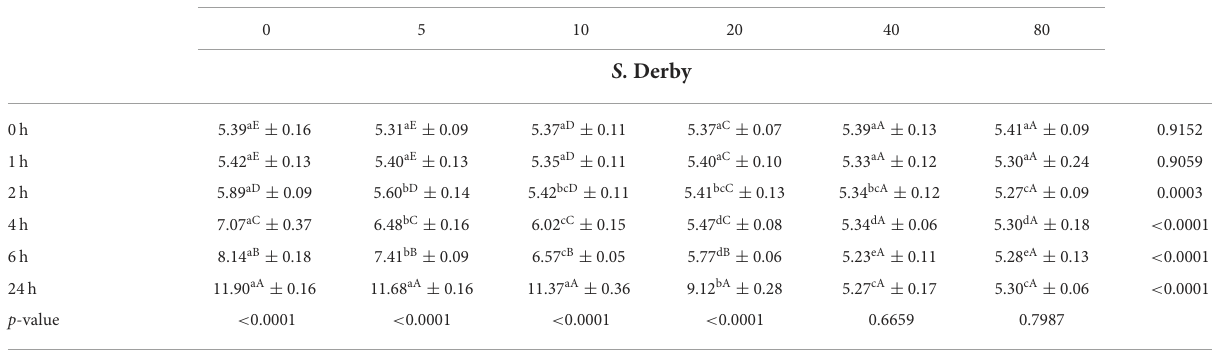
TABLE 2 Bacterial counts (mean ± SD) of S . Derby in log 10 CFU/mL in CAMHB 1 adjusted to a pH value of 6.0 exposed to different sodium butyrate concentrations at different incubation times, showing influence of concentration and incubation time ( n = 3). Incubation